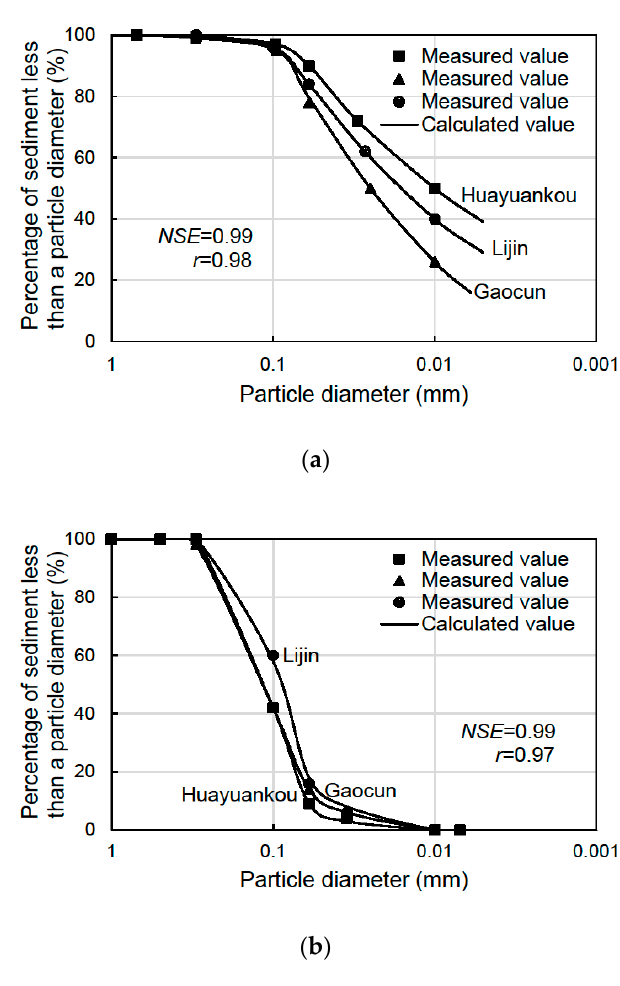
Figure 6. Verification results of sediment gradation. ( a ) suspended-load; ( b ) bed material.